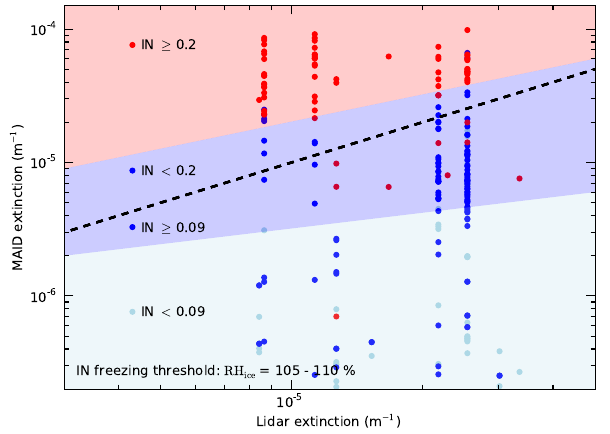
Fig. 6. MAID simulations of ice particle concentrations and cor- responding size for various IN concentrations. Under volcanic ash IN conditions (blue shaded area) with a IN concentration above 0.1cm − 3 and a freezing threshold of 105 to 110% (blueish dots) more but smaller ice crystals appear than under normal IN con- ditions (light blue shaded area) with a IN concentration below 0.09cm − 3 and a freezing threshold higher than 110% (yellow- reddish